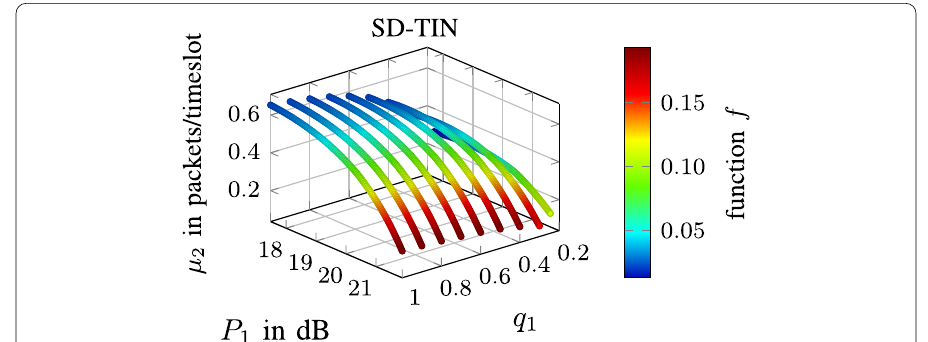
Fig. 7 ( µ 2 , function f aw ) versus ( q 1 , P 1 ), under congestion-aware randomized policy in SD-TIN. The rest of the parameters are the following: (cid:31) 1 = 0.1 , γ 1 = − 4.2dB , γ 2 = − 6.4dB , α = 2.2 , β = 41dB , P J = 23dB , q 2 = 0.4 , B = 6 packets, P max = 23dB , d 2 = 14.6m , and d 12 = 10m . In SD-TIN, d 1 = 8.2m